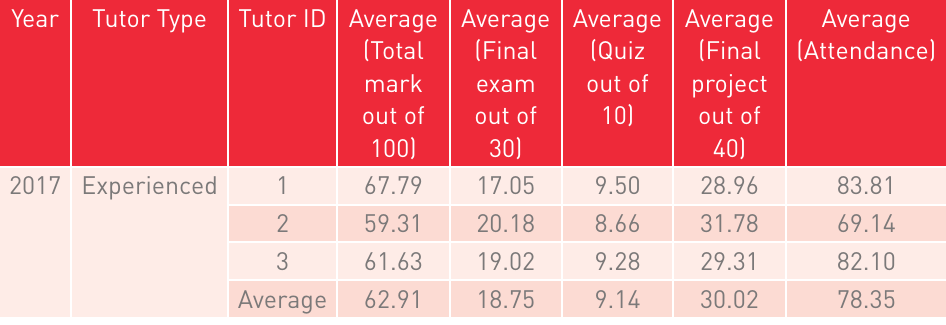
Comparison of students’ performance for novice and experienced